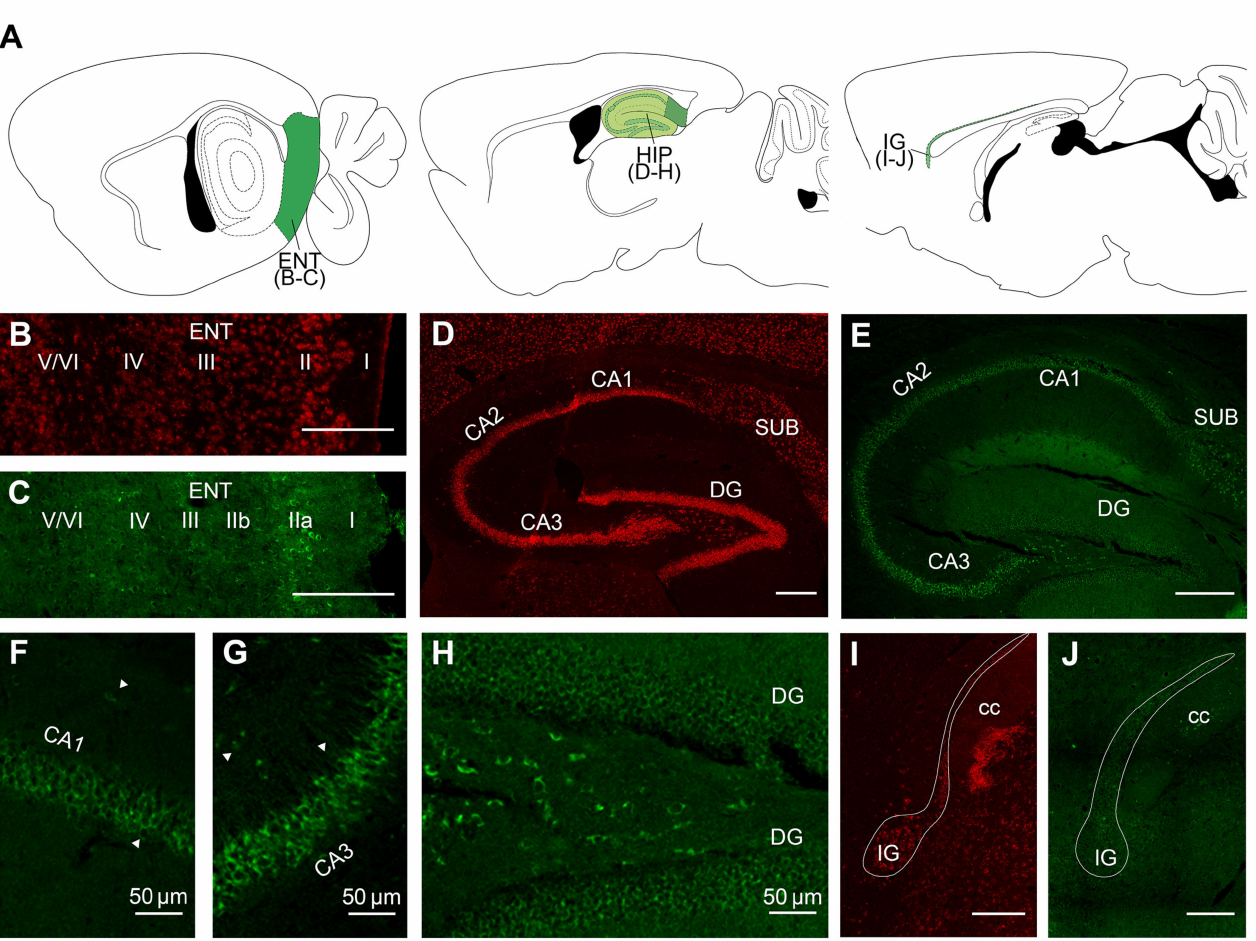
and protein (green) in the representative sagittal section of the mouse brain. Specific brain regions with detected expression were ( B – D ) frontal cortex, ( E – H ) somatosensorial cortex, ( I,J ) striatum, ( K,L ) globus pallidus, ( M,N ) substantia nigra, ( O – Q ) thalamus, and ( R , S ) subthalamic nucleus. CTX, cortex; cc, corpus callosum; CP, caudoputamen; GP, globus pallidus; I, II, III, IV, V and VI are cortical layers; SN, substantia nigra; PVT, paraventricular nucleus of the thalamus; TH, thalamus; RT, reticular nucleus of the thalamus; STN, subthalamic nucleus; and ZI, zona incerta. n = 3. Scale bar 250 µ m.